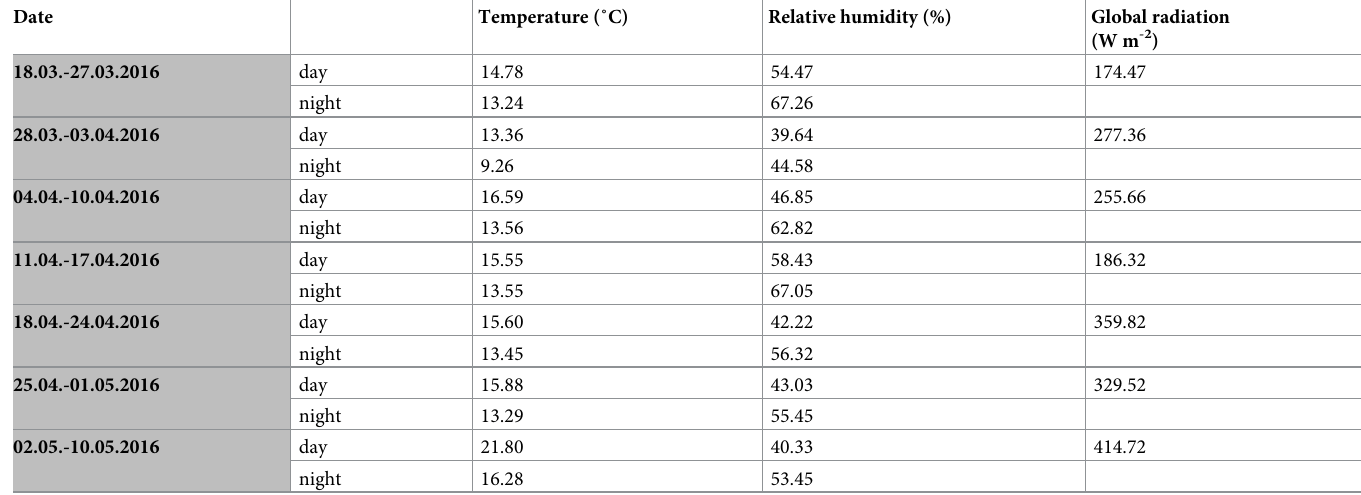
Table 1. Greenhouse climate during the experimental period of 7 weeks. The data represent the weekly mean values of temperature, relative humidity, carbon dioxide (CO 2 ), and global radiation. Except global radiation, the mean values during daytime and night time are shown. For global radiation only the values for daytime are displayed.